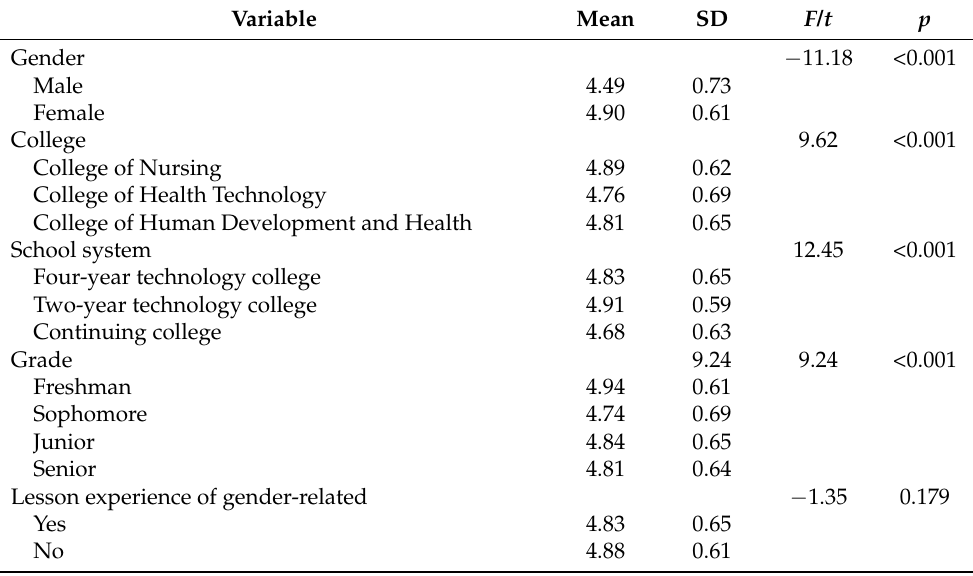
Table 3. The research subject’s basic attributes to their attitudes toward GE in employment ( n = 2855). Variable